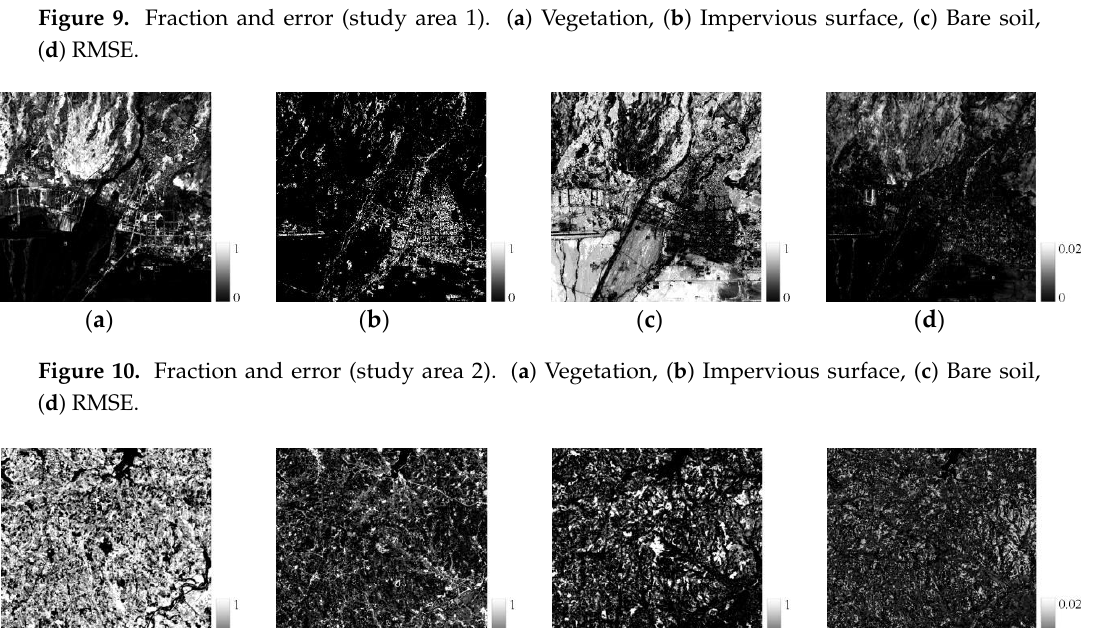
Figure 9. Fraction and error (study area 1). ( a ) Vegetation, ( b ) Impervious surface, ( c ) Bare soil, ( d )